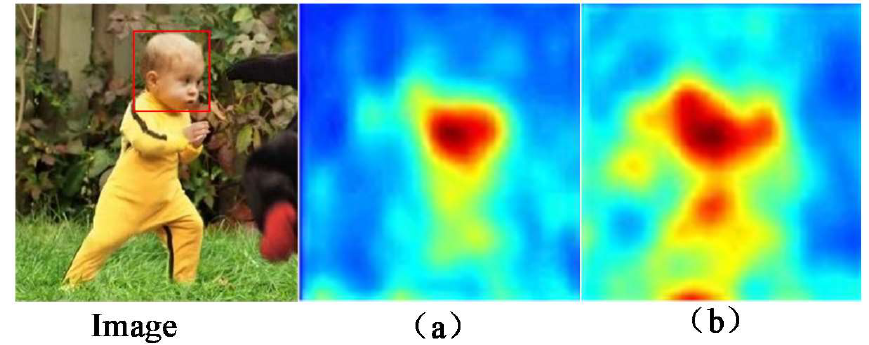
Figure 3. Comparison of the before and after learning characteristics of attentional learning loss. Finally, the regression weights w (cid:48) are mapped by the sigmoid function to obtain the channel weights corresponding to the sample